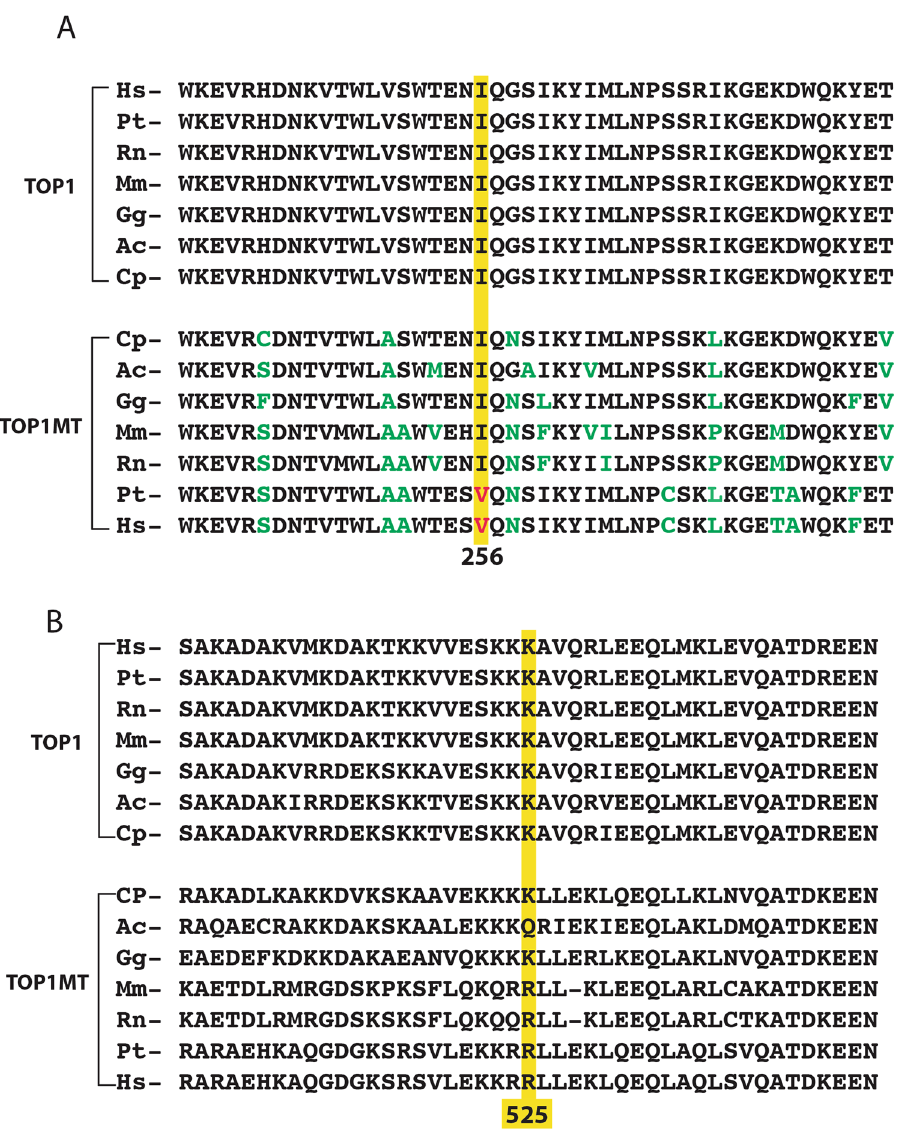
Figure 2. The V256I and R525W variants correspond to highly conserved regions of TOP1MT across species. ( A ) Alignment of the TOP1 and TOP1MT sequences corresponding to the V256I site. ( B ) Alignment of the TOP1 and TOP1MT sequences corresponding to the R525W site. Hs, Homo sapiens ; Pt, Pan troglodytes ; Rn, Rattus norvegicus ; Mm, Mus musculus ; Gg, Gallus gallus ; Ac, Anolis carolinensis ; Cp, Chrysemys picta .